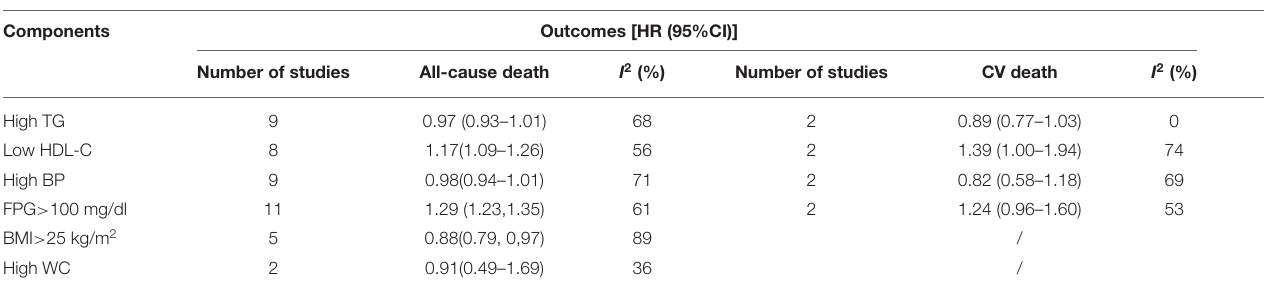
TABLE 4 | The results of metabolic syndrome’s